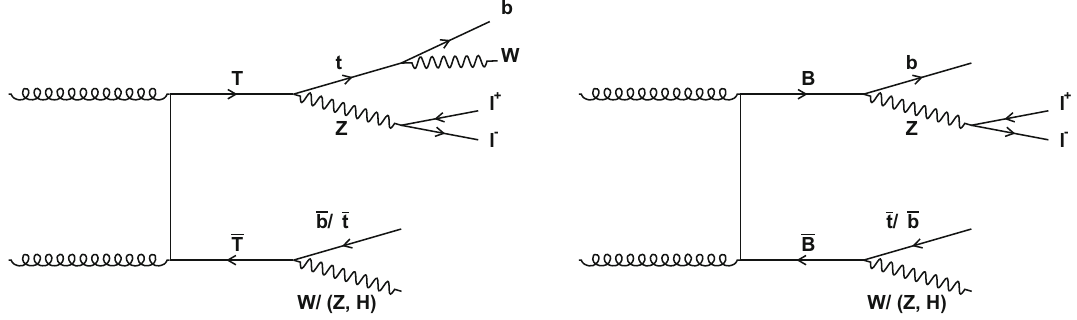
Fig. 1 Leading-order Feynman diagrams for the pair production and decay of T (left) and B (right) VLQs relevant to final states considered in this